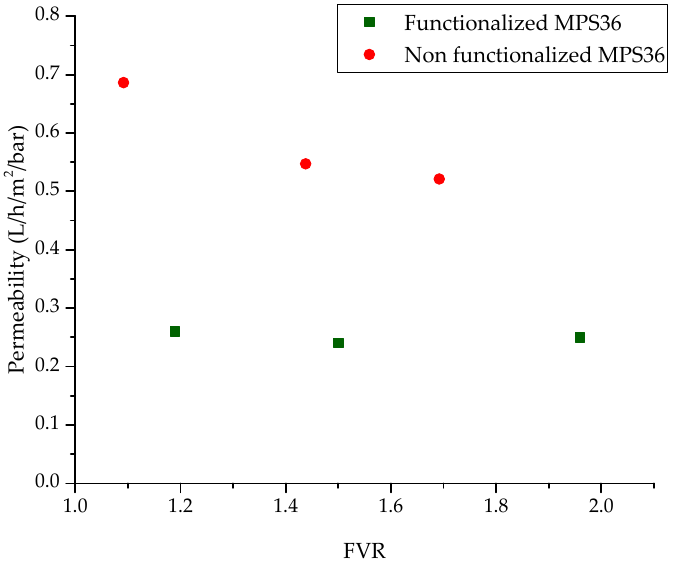
Figure 3. The permeability variation of MPS36 and functionalized MPS36 versus the factor of volume reduction (FVR).